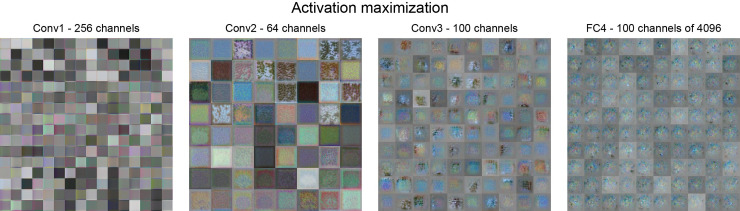
Static snapshots of activation maximization results for each layer.Layer fully connected 4 (FC4) has 4096 units and we randomly picked 100 for this figure. We recommend S3 Video for visualizations of the temporal effects.